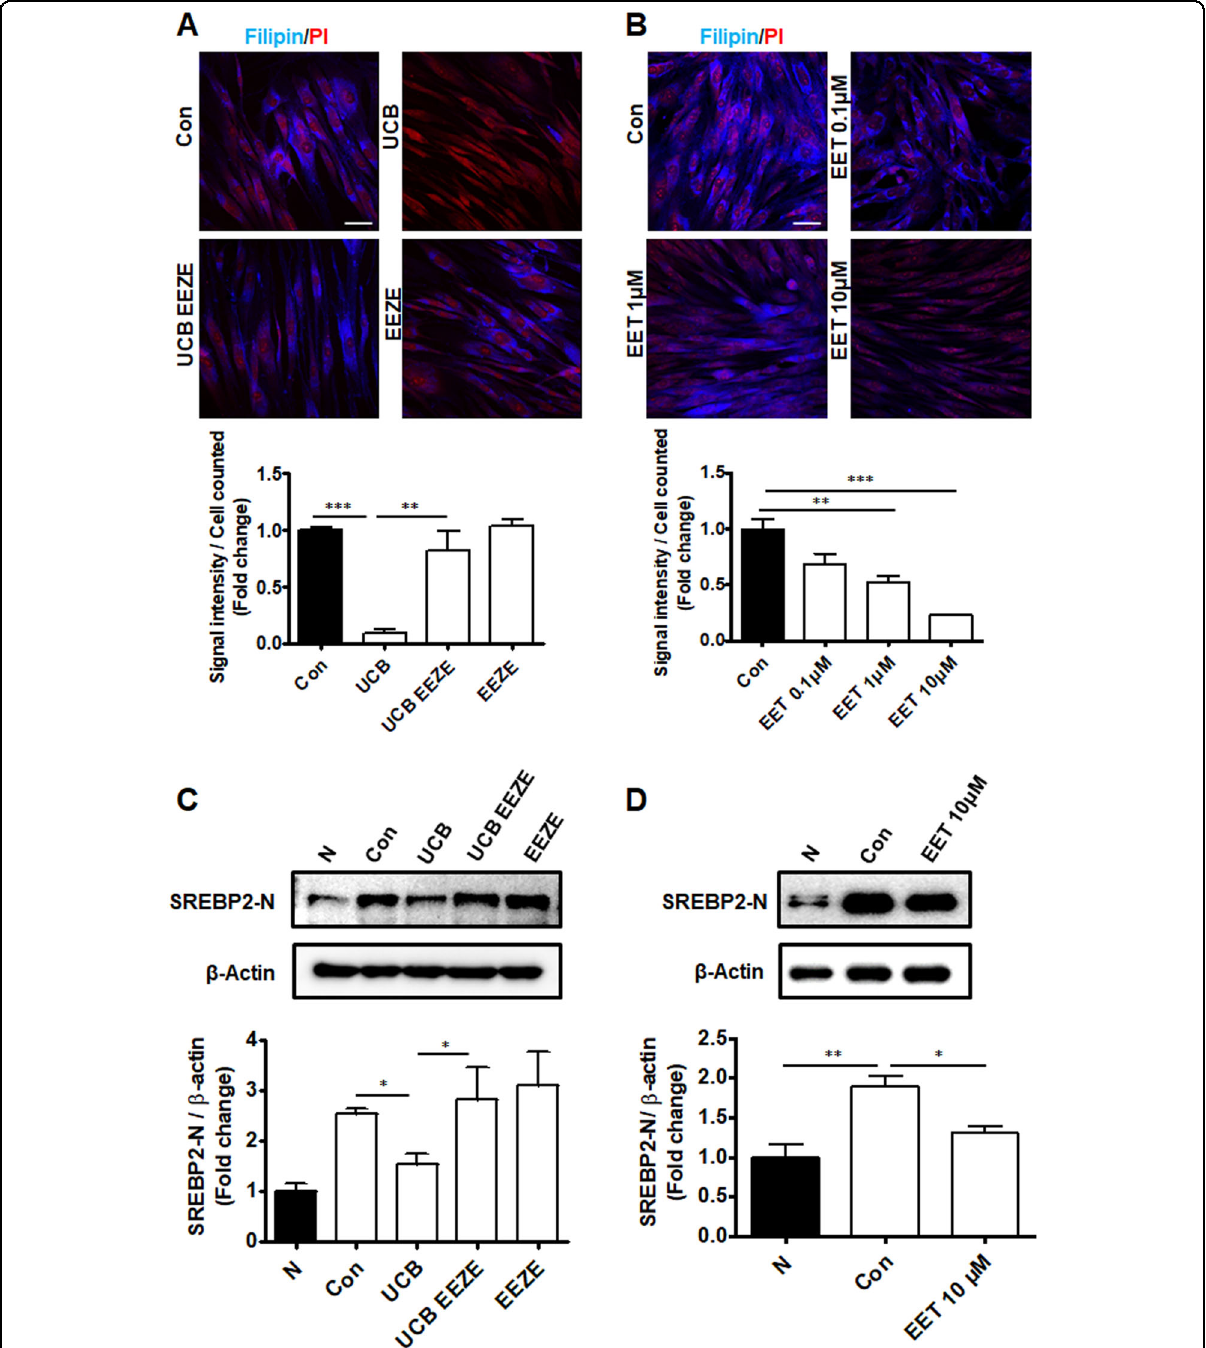
Fig. 5 14,15-EET rescues cholesterol accumulation. a Representative in vitro fl uorescence image of NPC1 patient fi broblasts (Con) labeled with PI and the cholesterol detection marker fi lipin. Co-culture with hUCB-MSCs (UCB) signi fi cantly reduces the accumulation of cholesterol in NPC1 patient fi broblasts. When EEZE is treated during the co-culture of hUCB-MSCs and NPC1 patient fi broblasts (UCB EEZE), cholesterol accumulation can be observed in the fi broblast. A single treatment of EEZE in NPC1 patient fi broblasts has no effect on cholesterol accumulation (EEZE). The intensity of fi lipin was quanti fi ed and normalized to non-treated NPC1 patient fi broblasts. b 14,15-EET was administered to NPC1 patient fi broblasts (Con) in three independent doses (0.1, 1, and 10 μ M) and stained with fi lipin. The intensity of fi lipin was quanti fi ed and normalized to non-treated NPC1 patient fi broblasts. c Immunoblot analyses with anti-SREBP2 and anti-actin antibodies in normal fi broblasts (N), NPC1 patient fi broblasts (Con), hUCB- MSC-treated NPC1 patient fi broblasts (UCB), hUCB-MSC-co-treated and EEZE-co-treated NPC1 patient fi broblasts (UCB EEZE), and EEZE-treated NPC1 patient fi broblasts (EEZE). d Immunoblot analyses with anti-SREBP2 normalized by anti-actin antibodies in normal fi broblasts (N), NPC1 patient fi broblasts (Con), and 14,15-EET-treated NPC1 patient fi broblasts (10 μ M), (EET 10 μ M). The cleaved nuclear forms of SREBP2 are shown (SREBP2-N). Scale bars = 50 μ m. All data represent the mean ± SD. * P < 0.05; ** P < 0.01; *** P < 0.001 Of fi cial journal of the Korean Society for Biochemistry and Molecular